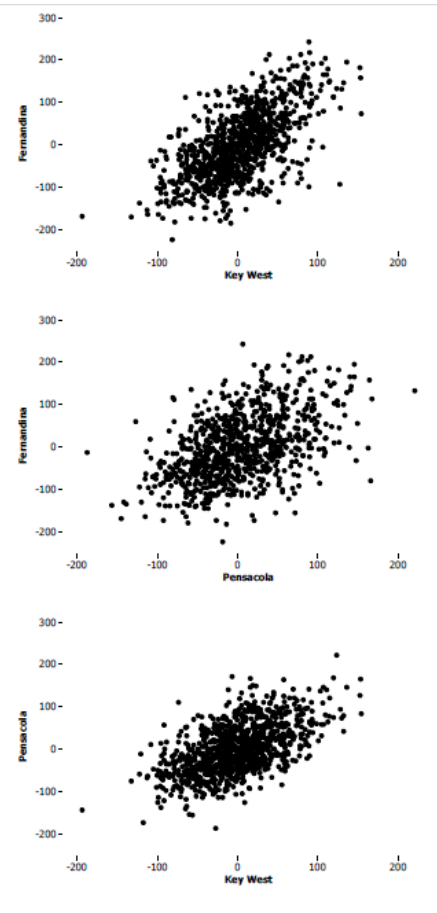
Figure 4. Geographical correlation among the Fernandina, Key West, and Pensacola stations’ residuals. The correlation coefficients (on the order of 0.63, 0.48, 0.56 respectively) and the corresponding covariances listed in Tab. 3 are sta- tistically significant ( p < 0.00).